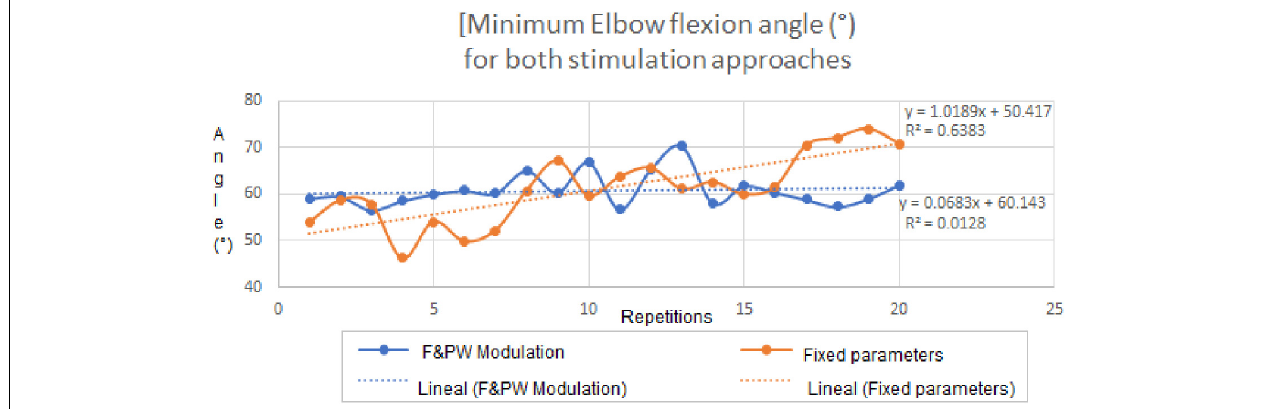
FIGURE 9 | Elbow joint angles for the fixed parameters and co-modulation stimulation protocols throughout the 20 repetitions of the “bottle to mouth” functional task. Linear regression equations and plots for the achieved angles with each stimulation protocol, are shown inside the